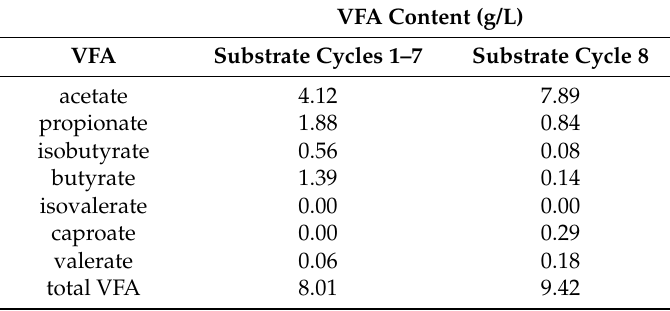
Table 1. Volatile fatty acid (VFA) content of the two effluent collections used as